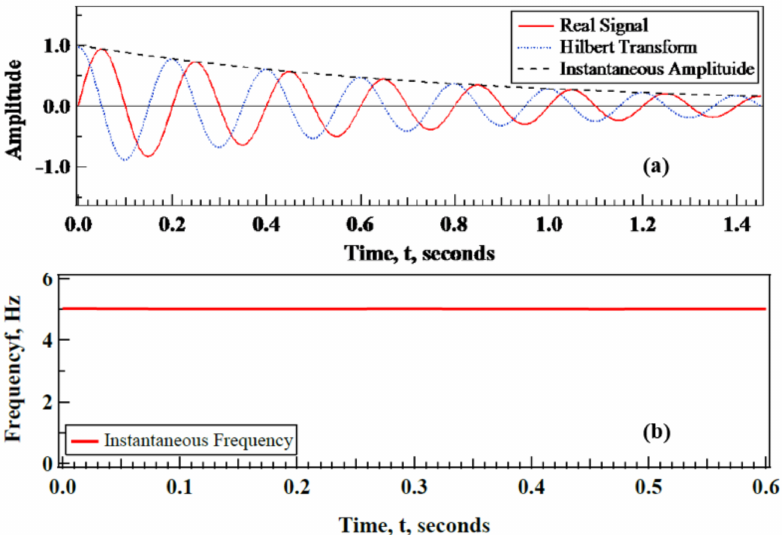
Figure 14. Plots of ( a ) real signal, Hilbert Transform, instantaneous amplitude, and ( b ) instantaneous frequency versus time